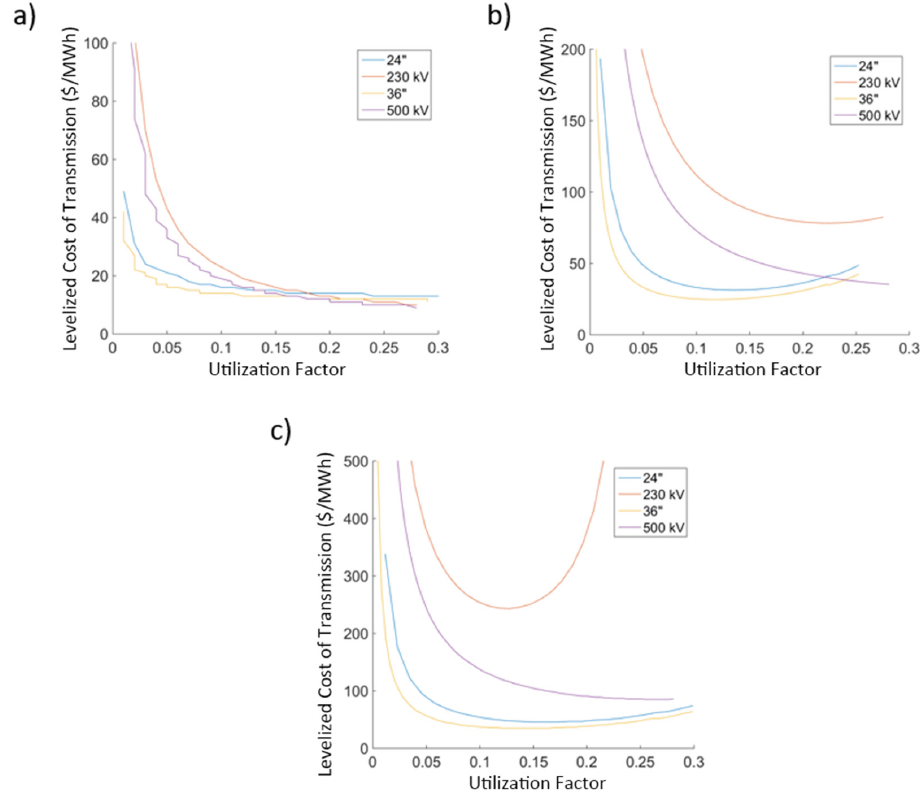
Figure 3. Levelized cost of transmitting energy versus utilization factor for ( a ) 100 miles, ( b ) 500 miles, and ( c ) 900 miles.